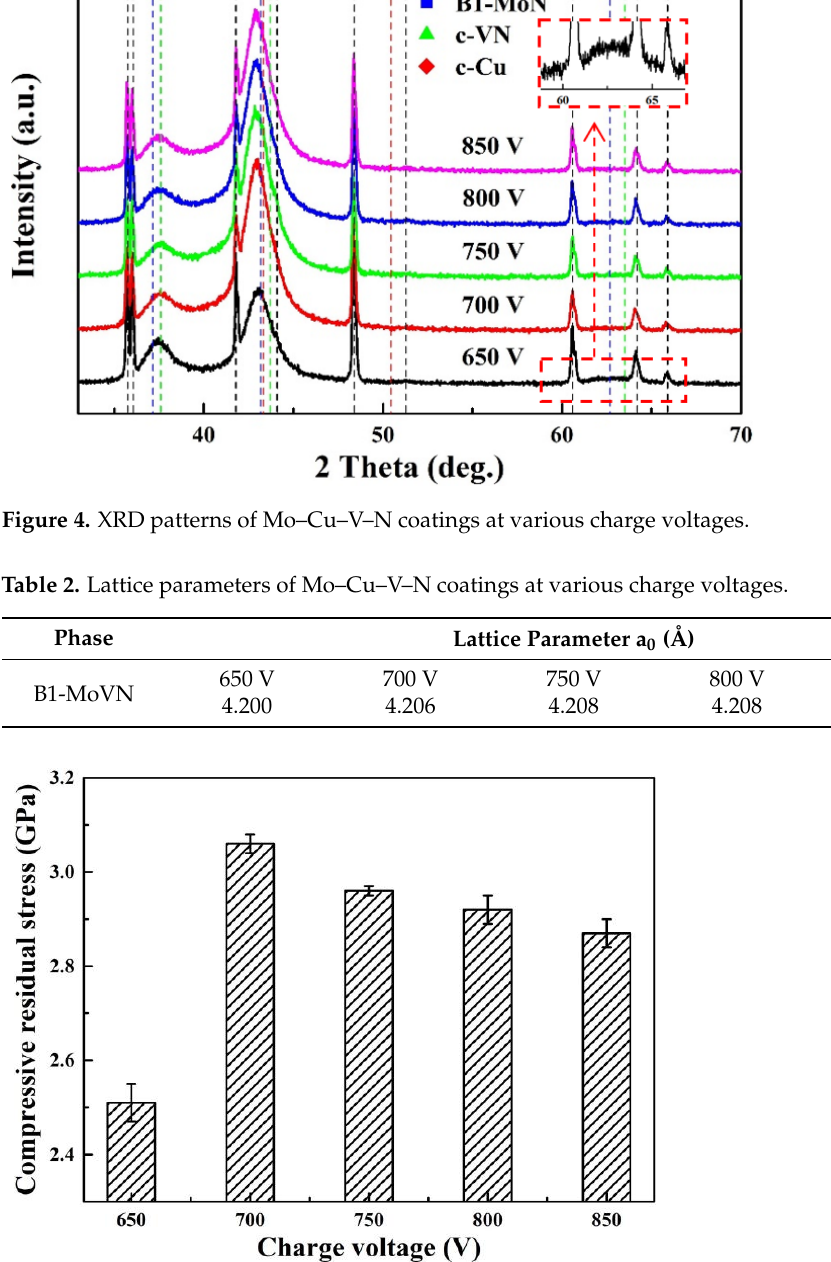
Table 2. Lattice parameters of Mo–Cu–V–N coatings at various charge voltages. Phase Figure 5. Residual stress of Mo–Cu–V–N coatings at various charge voltages. Figure 5. Residual stress of Mo–Cu–V–N coatings at various charge